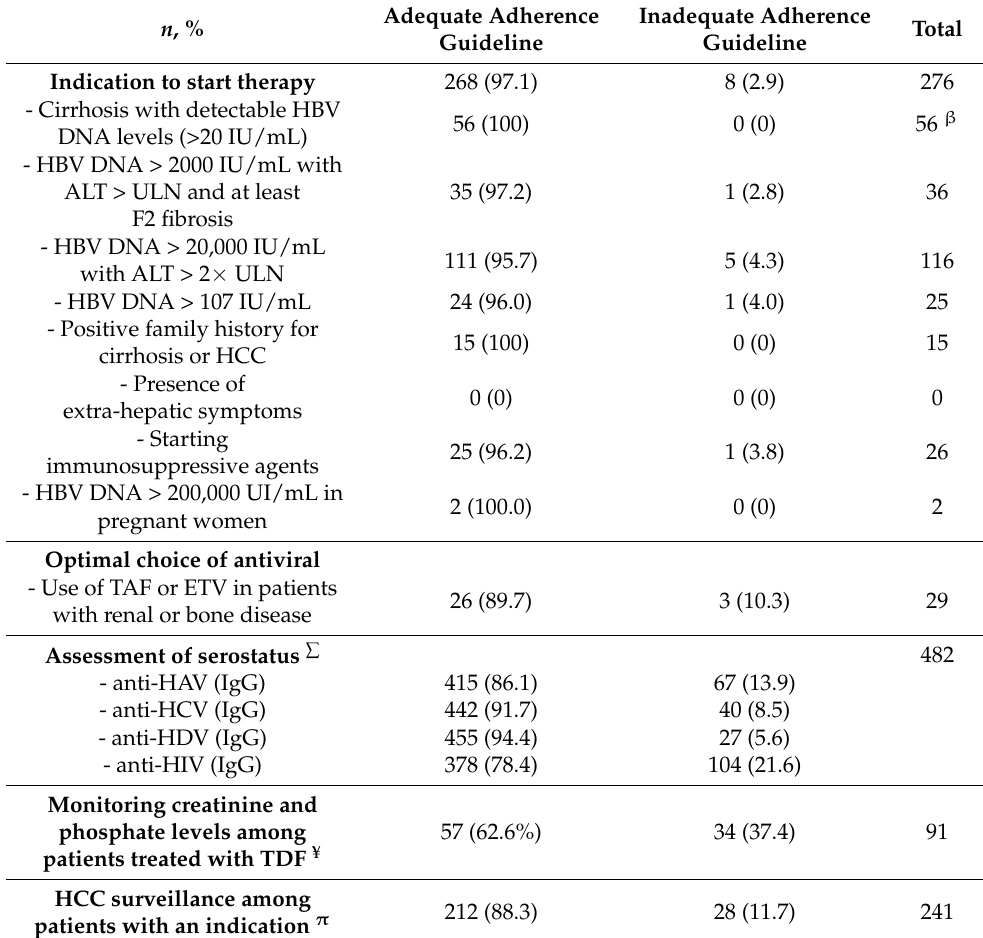
Table 2. Adherence of clinical guideline [1]. n ,